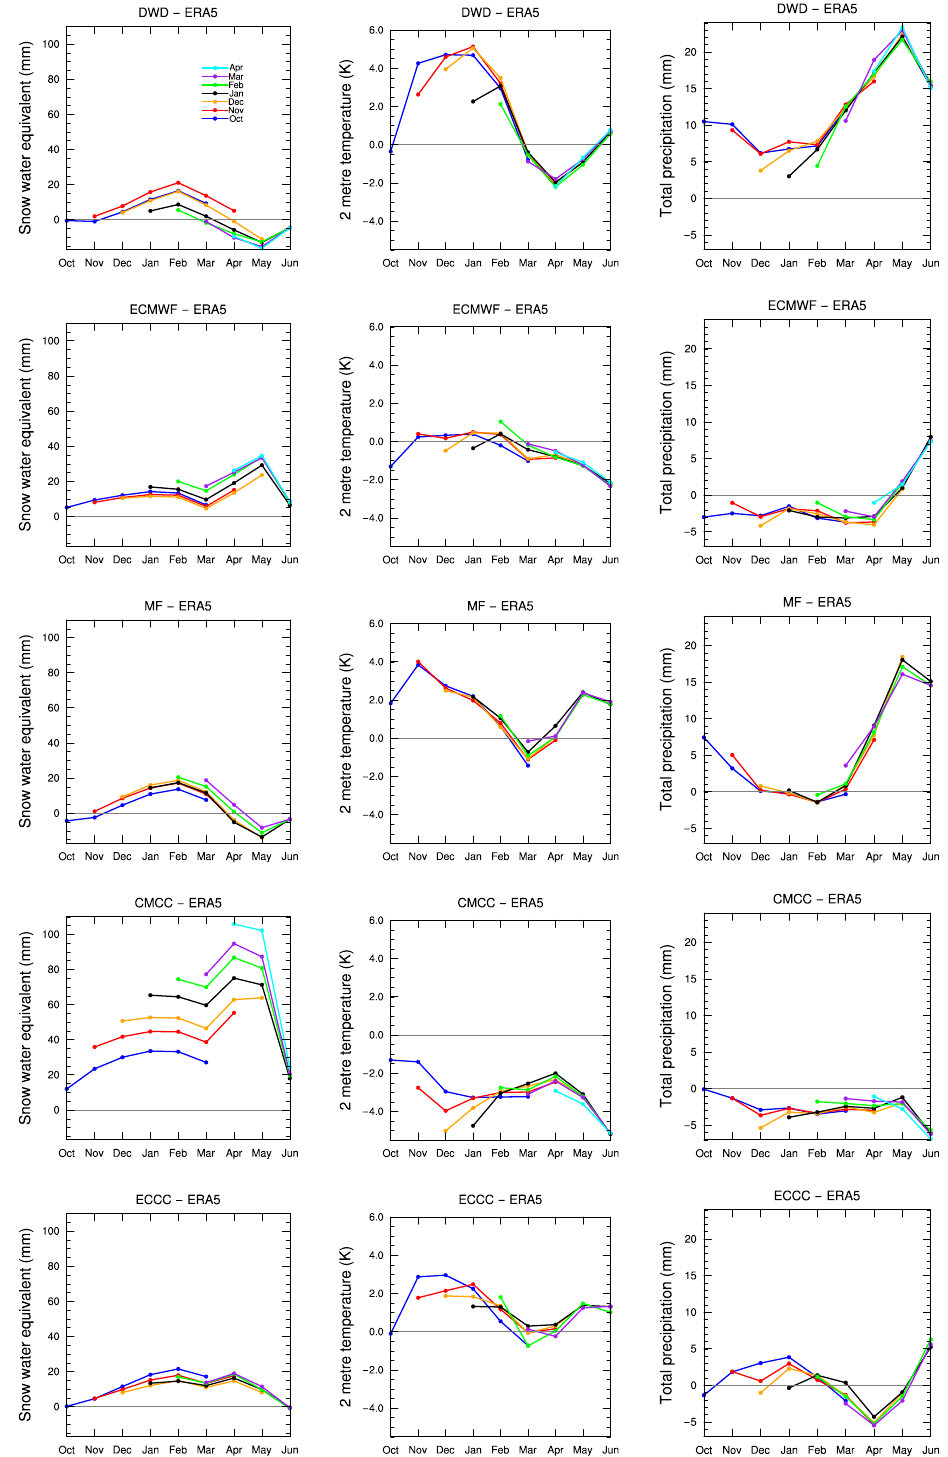
Figure 2. Biases of SWE, 2-m temperature, and total precipitation averaged over the domain and all years of monthly data from hindcasts (1993 to 2016) with ERA5 as reference. Relative biases are shown for SWE and total precipitation, and absolute biases for 2-m temperature. Colors indicate different starting